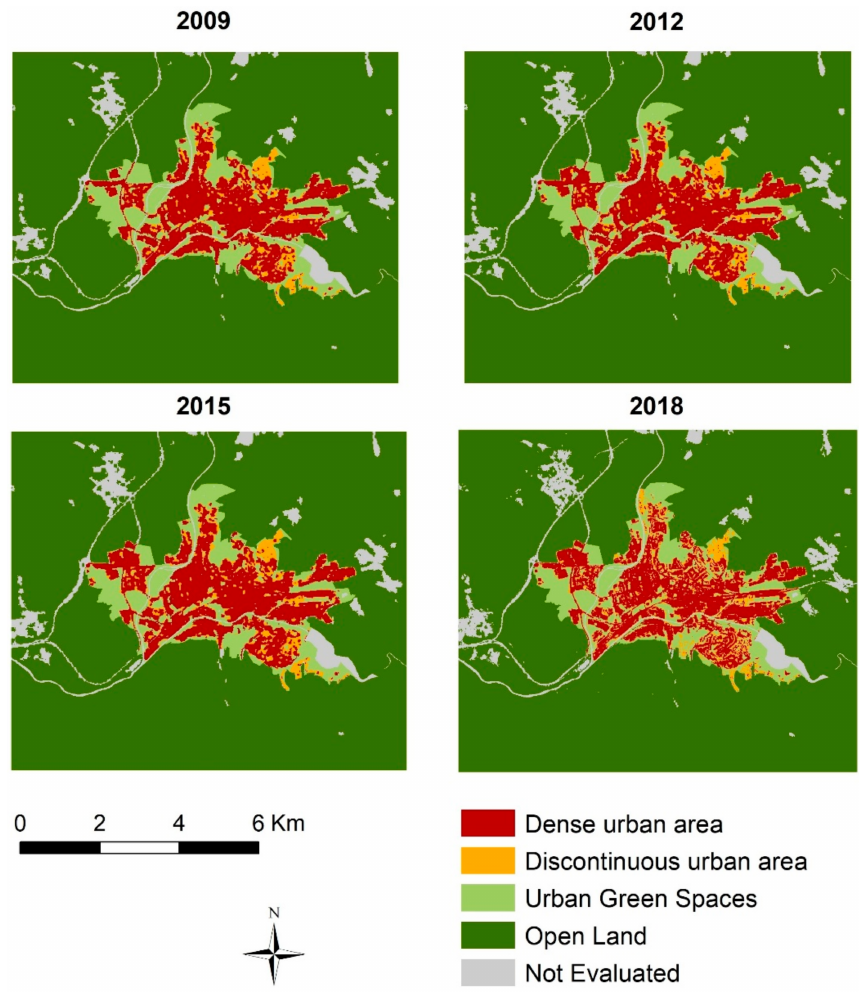
Figure 2. Urban zones in the respective